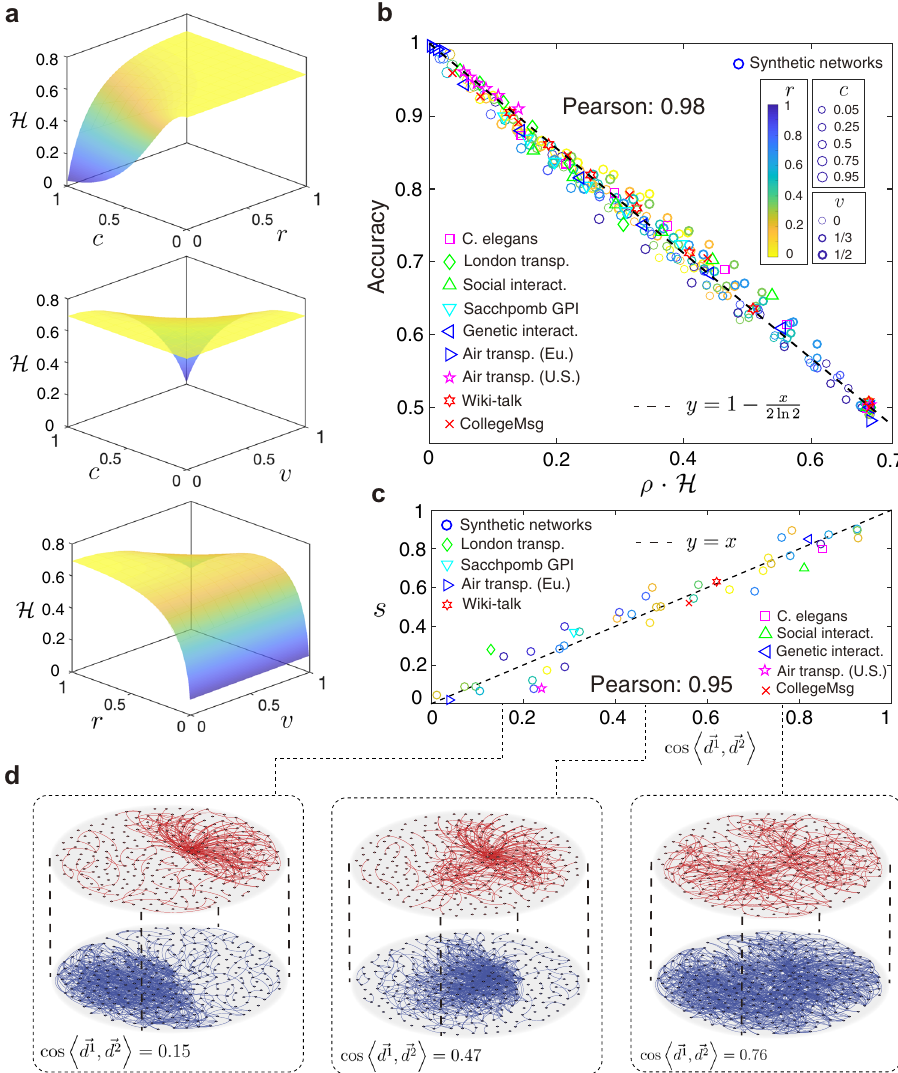
Fig. 4 The impact of multiplex network characteristics on reconstruction. a The discrimination indicator for reconstruction is in fl uenced by c (fraction of partial observations), r (ratio of average degrees), and v (overlap of edges). b The relationship between accuracy of reconstruction and the discrimination indicator ( ρ (cid:3) H ) for nine real-world networks and several synthetic networks in two dimension, showing the discrimination indicator is a good predictor (Pearson correlation is 0.98) for accuracy of reconstruction. c The correlation (Pearson correlation is 0.95) between the parameter s (M) and ! ! ; d 2 the cosine similarity of two degree sequences, cos h d 1 i , for nine real-world networks and several synthetic networks in two dimension, where the parameter s for different multiplex networks are shown in Supplementary Table 2. d Three synthetic networks corresponding to the degree